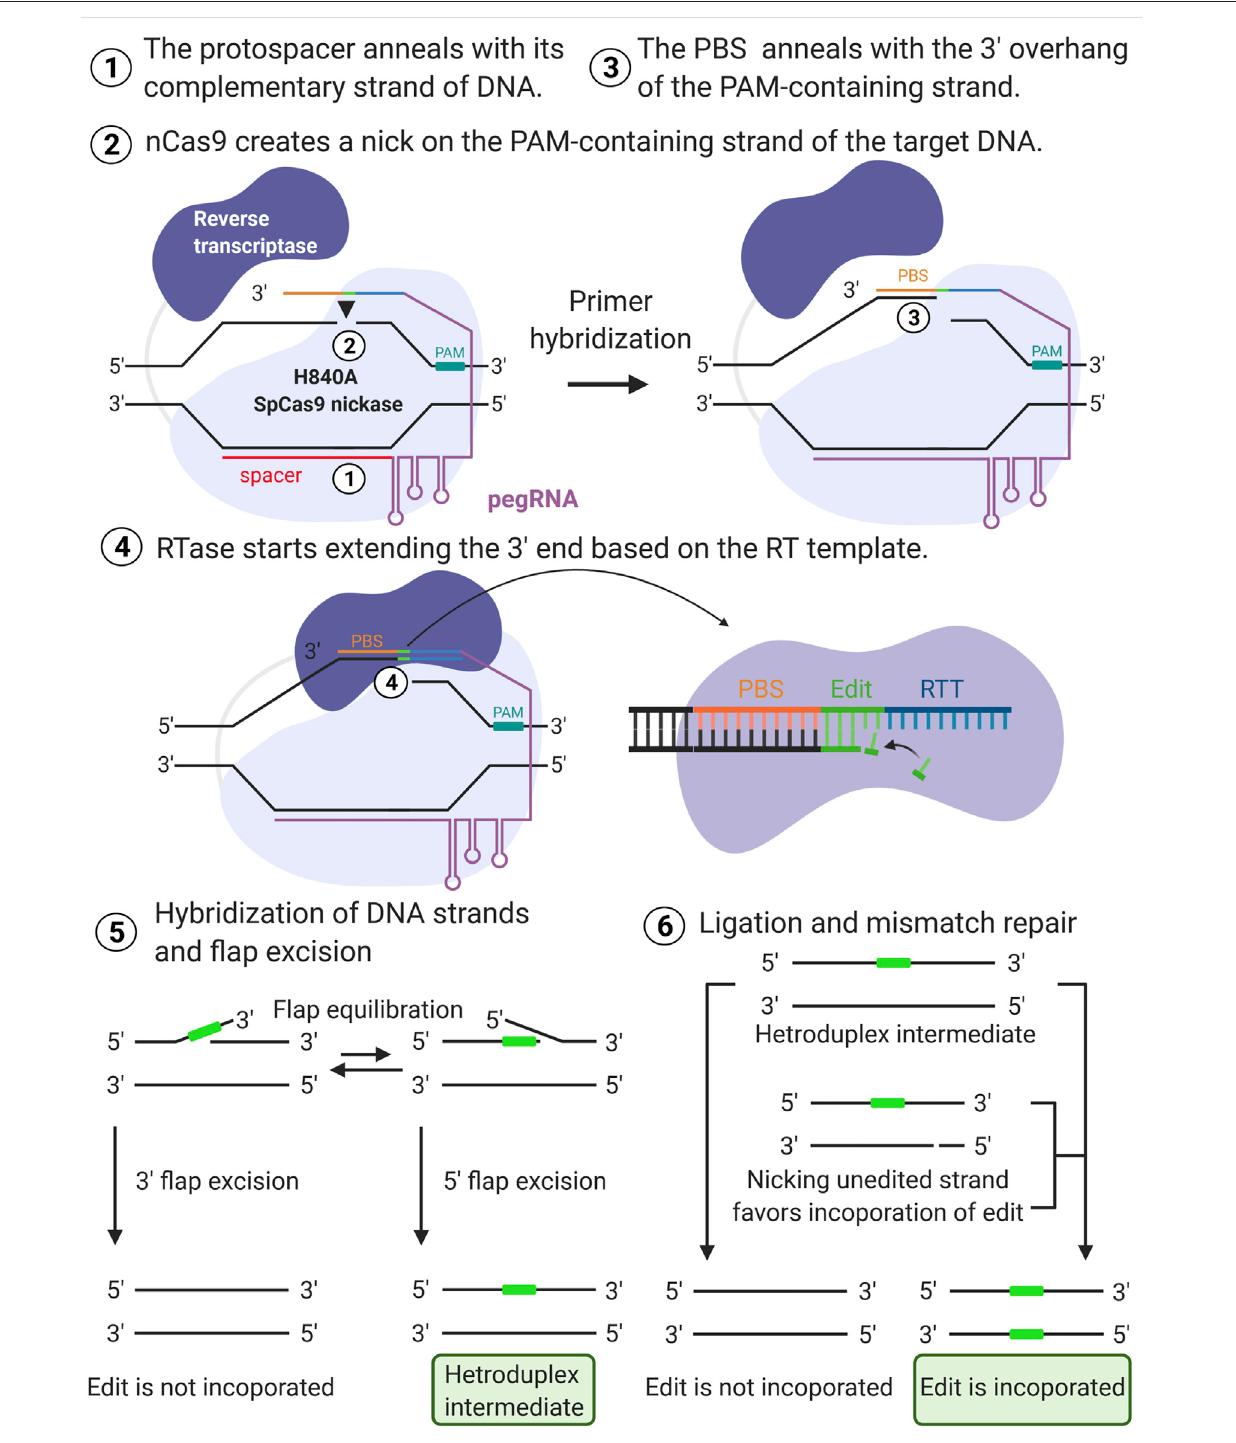
FIGURE2| Overviewofprimeeditingmechanism.Thespacer(redline)annealswithitscomplementarystrandoftheDNA (1) directingtheH840ASpCas9nickase tonickthePAM-containingstrand(blackarrow)ofthetargetDNA (2) .Theprimerbindingsequence(PBS)thenhybridizeswiththenickedDNA (3) initiatingtheelongation of the free 3 ′ end according to the reverse transcription template (RTT) sequence that carries the intended edit (4) . The newly synthesized strand leads to either 3 ′ or 5 ′ fl ap excision. The excision of the 5 ′ fl ap is favored, and it leads to the heteroduplex formation (5) . The replacement of the original sequence via endogenous DNA mismatch repair mechanism incorporates the desired mutation at the target site (6) . “ Created with BioRender ” .